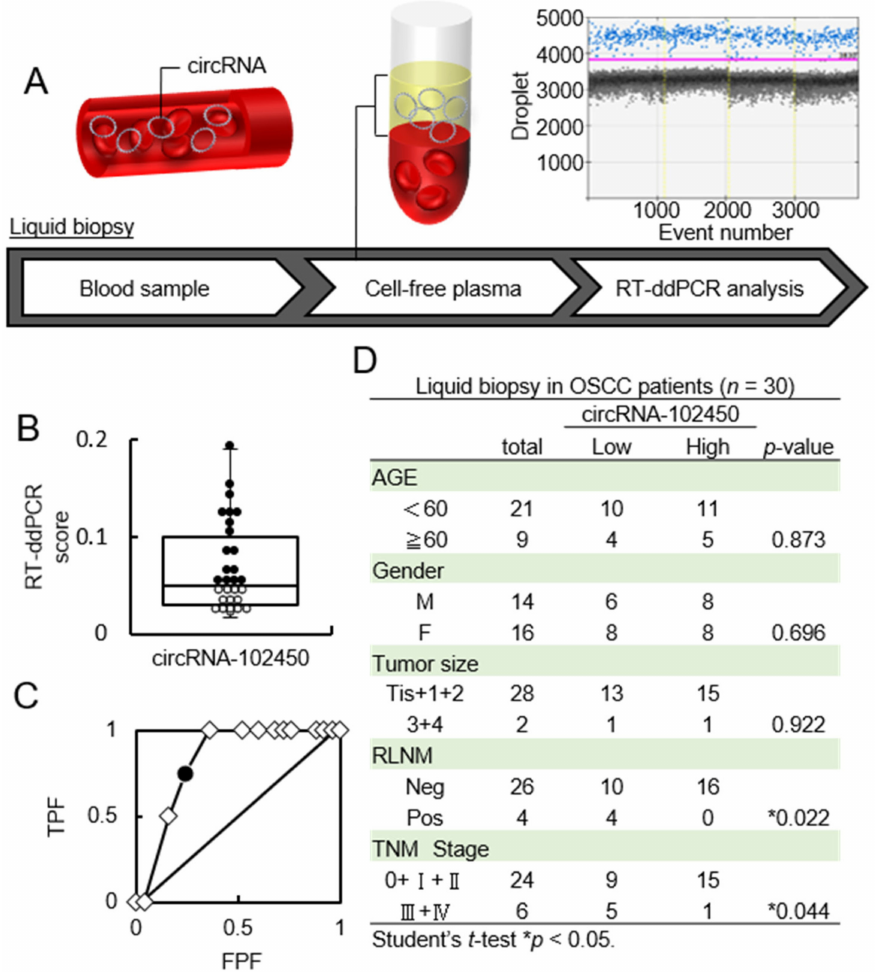
Figure 4. Investigation of the circRNA-102450 level in LB samples. ( A ) Workflow of the quantification of circRNA-102450 expression in LB samples from OSCC patients ( n = 30). ( B ) The RT-ddPCR scores for circRNA-102450 in LB samples ( • > The cutoff score, ◦ ≤ The cutoff score). The scores for circRNA-102450 ranged from 0.017 to 0.19 (median, 0.05). ( C ) ROC analysis of the circRNA-102450 score. The area under the ROC curve was 0.835, and the cutoff score was 0.04( • = The cutoff score, = Plot). ( D ) Relationships between clinical parameters and circRNA-102450 (cid:51)